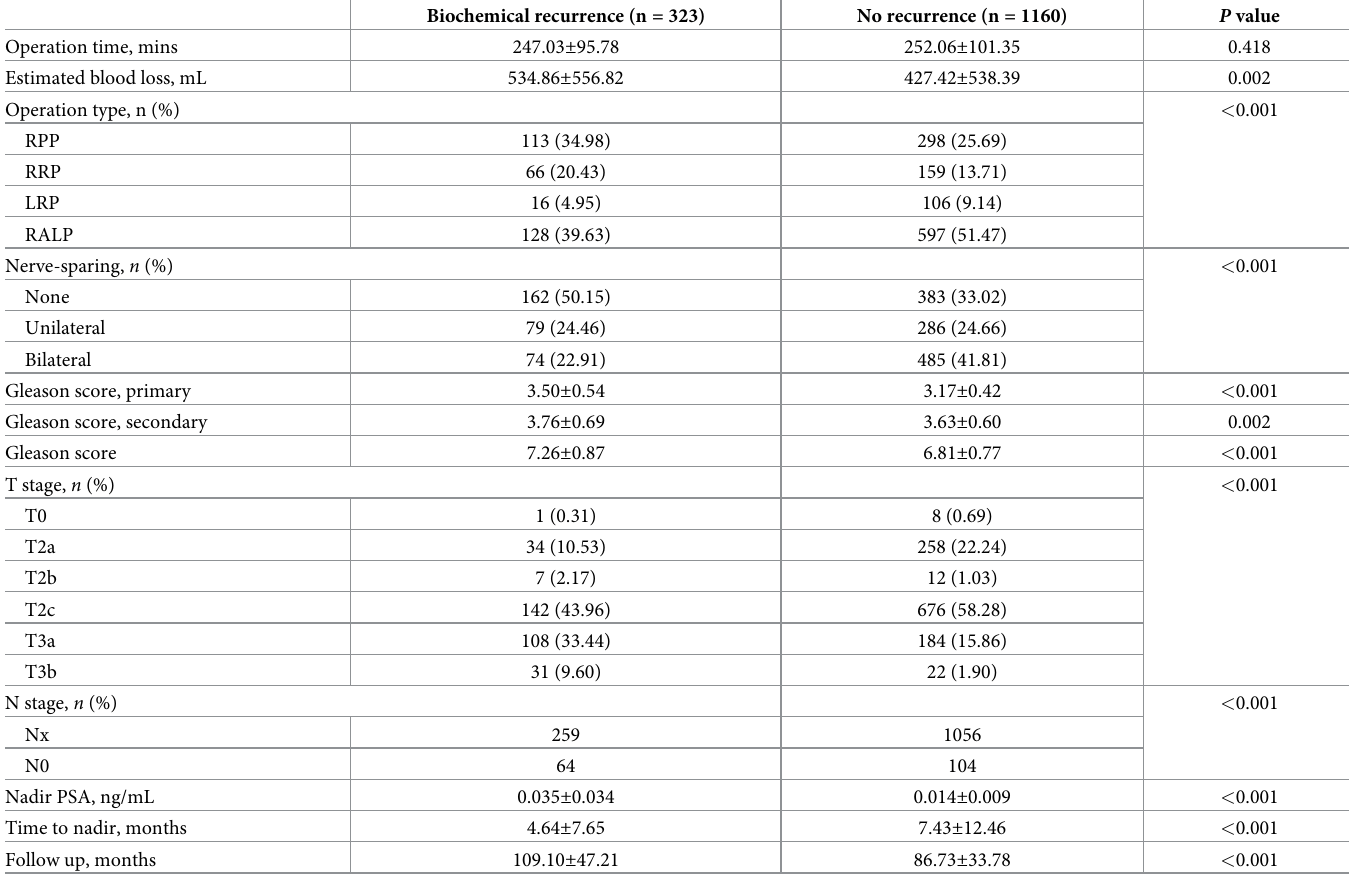
Table 2. Operative and post-operative outcomes of the biochemical recurrence versus no recurrence